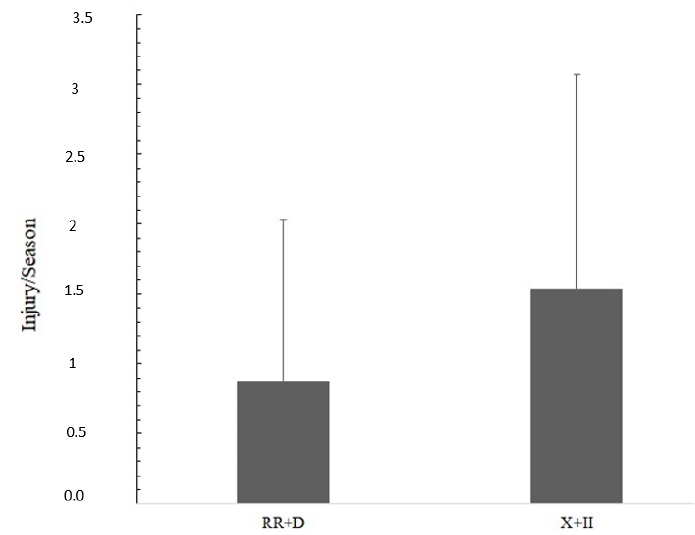
Figure 3. ACTN3 R577X and ACE I/D interaction on the incidence of muscle injury per season, adjusted by weight and age ( p =